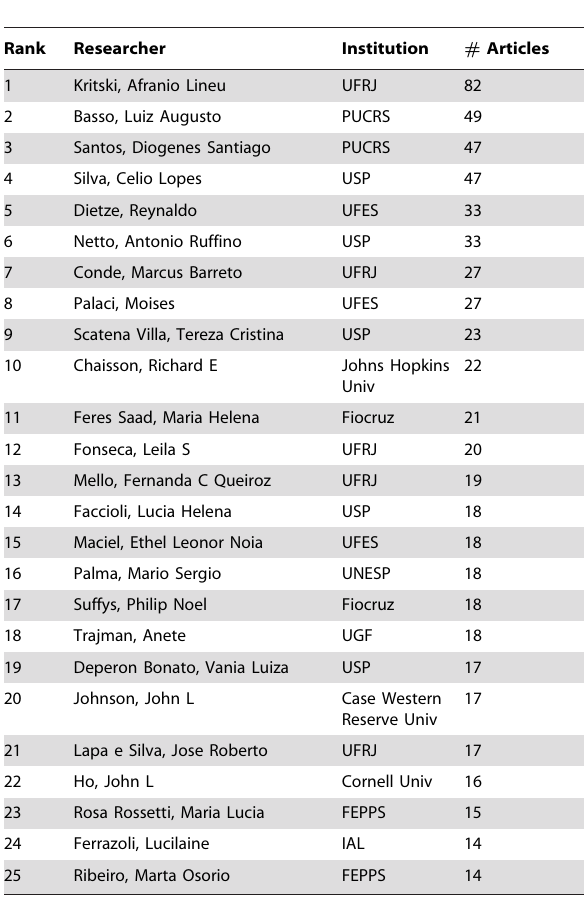
Table 1. Journals publishing 5 or more articles on tuberculosis with Brazilian authors, 1995–2010.